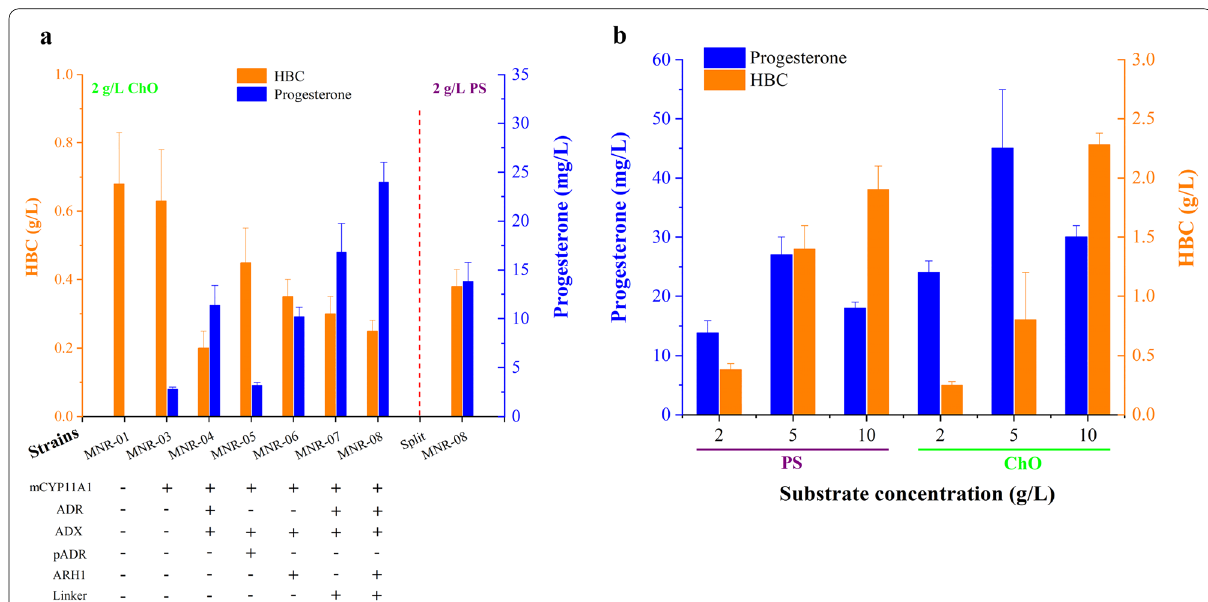
Fig. 4 a P450 module optimization screen. For strain details, please see appendix, Additional file 1: Table S1. b The effect of substrates on progesterone production in pH 7.4 PBS by 20 g/L resting MNR‑08 conversion for 5